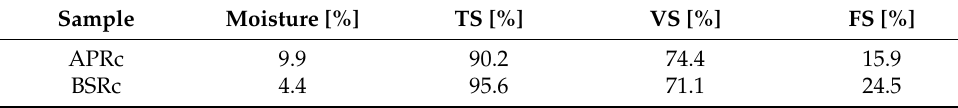
Figure 2. SEM images of BSRc: ( A ) untreated; ( B ) treated NaOH; ( C ) treated cellulase enzyme; ( D ) treated cellobiohydrolase enzyme; ( E ) treated with HCl. (Figure ( A ) it was made with a resolution of × 2000 and 10 µ m; figure ( B ) with a resolution × 10,000 and 1 µ m; the figures ( C – E ) were made with a resolution of × 5000 and 1 µ m). Table 2. Characterization of substrates on a dry